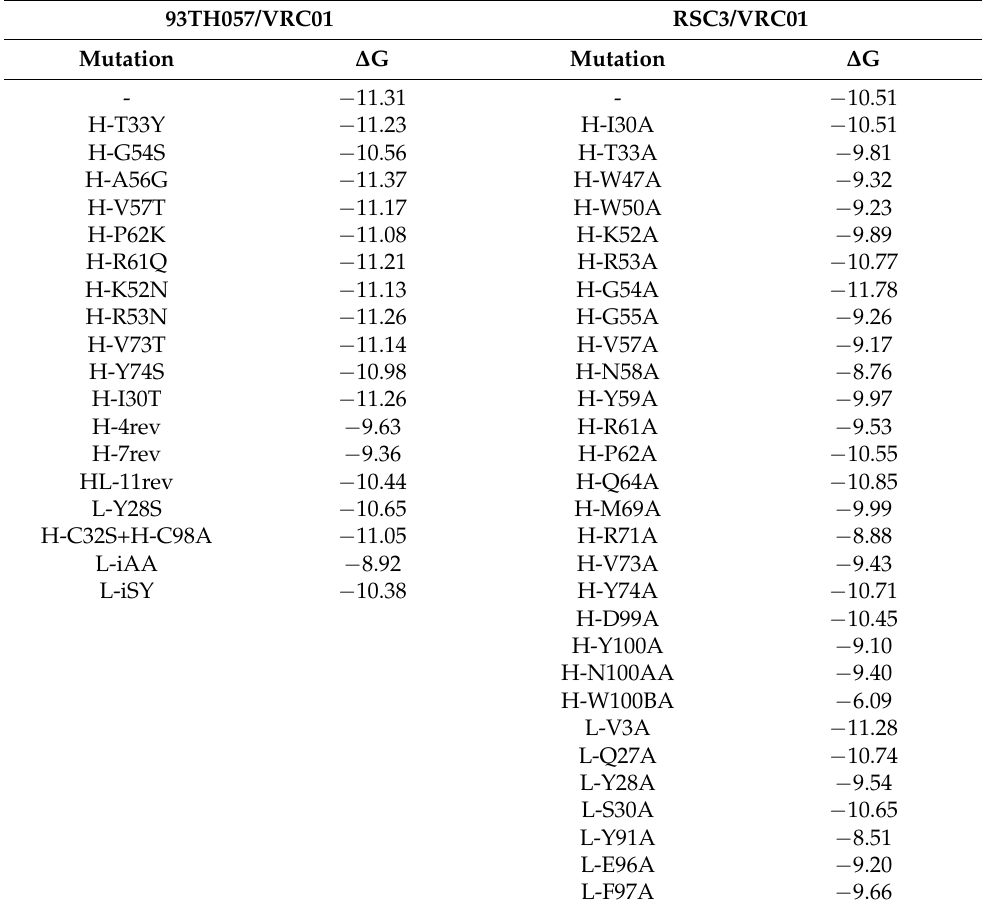
Table 1. Dataset of the 49 experimental binding affinities used in this work, adapted from Refs. [7,32]. Energies are expressed in units of kcal/mol. The prefix H- or L- indicates whether the mutation was made to the heavy or the light chain, respectively; letter pairs at the end of some of the mutants correspond to the residue insertion code relative to the germline sequence, followed by the 1-letter code of the residue after mutation. The reversion mutant definitions are taken from Table S10a in Ref. [32]. They are: H-4rev—A56G, V57T, P62K, V73T (heavy chain); H-7rev—T33Y, G55S, A56G, V57T, P62K, V73T, Y74S (heavy chain); HL-11rev chain: I30T, K52N, R53N, G54S, A56G, V57T, R61Q, P62K, V73T, Y74S (heavy chain), Y28S (light chain). 93TH057/VRC01 RSC3/VRC01 ∆